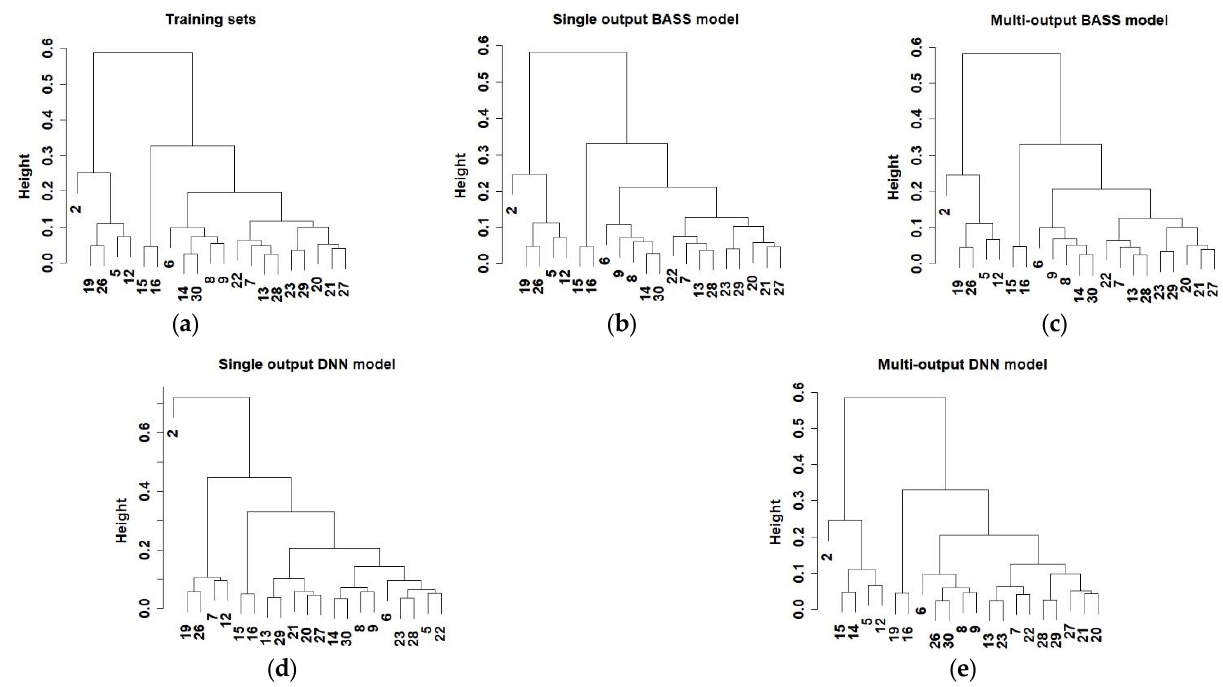
Figure 14. Dendrogram of January daily heating energy for the training set and four machine learning models.